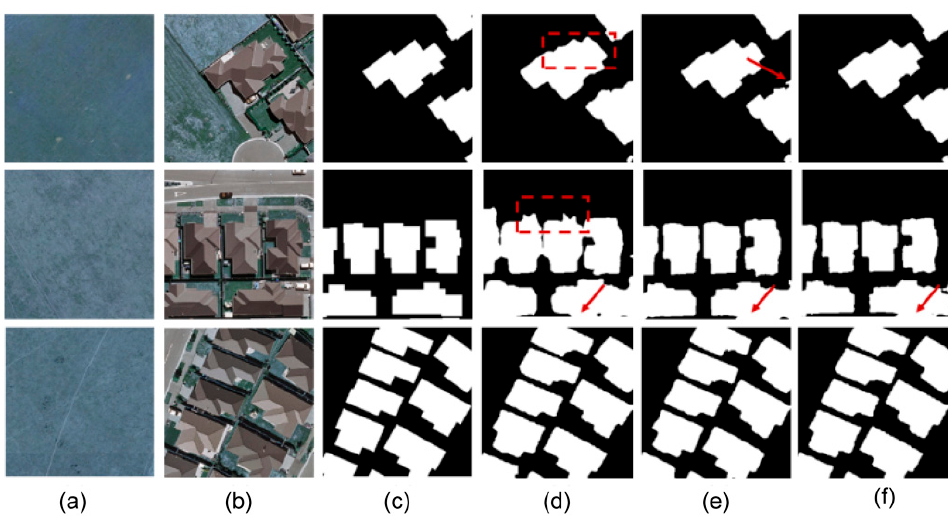
11 of 15 Figure 7. Comparison example of model experiment results on the Google dataset. ( a ) Image T1, ( b ) Image T2, ( c ) truth map of change detection, ( d ) the result of FC-Siam-diff, ( e ) the result of Unet++, and ( f ) the result of this paper. The red rectangular boxes and red arrows mark the differences be- tween the variogram (CM) and the true value graph (GT) given by the model. 4.4. Change Detection Results of the WHU Dataset The change detection results of the WHU dataset are shown in Figure 8. As can be seen in the first column of Figure 8, FC-Siam-diff and UNet++ had building boundary detection errors. Building changes were more accurately predicted by the dual multi-scale attention mechanism network proposed in this paper. From the second column of images,